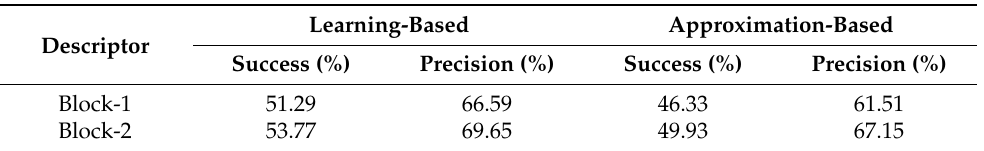
Table 5. Performance comparison between models using different solutions for the Jacobian problem. Each row shows results using a different feature block.